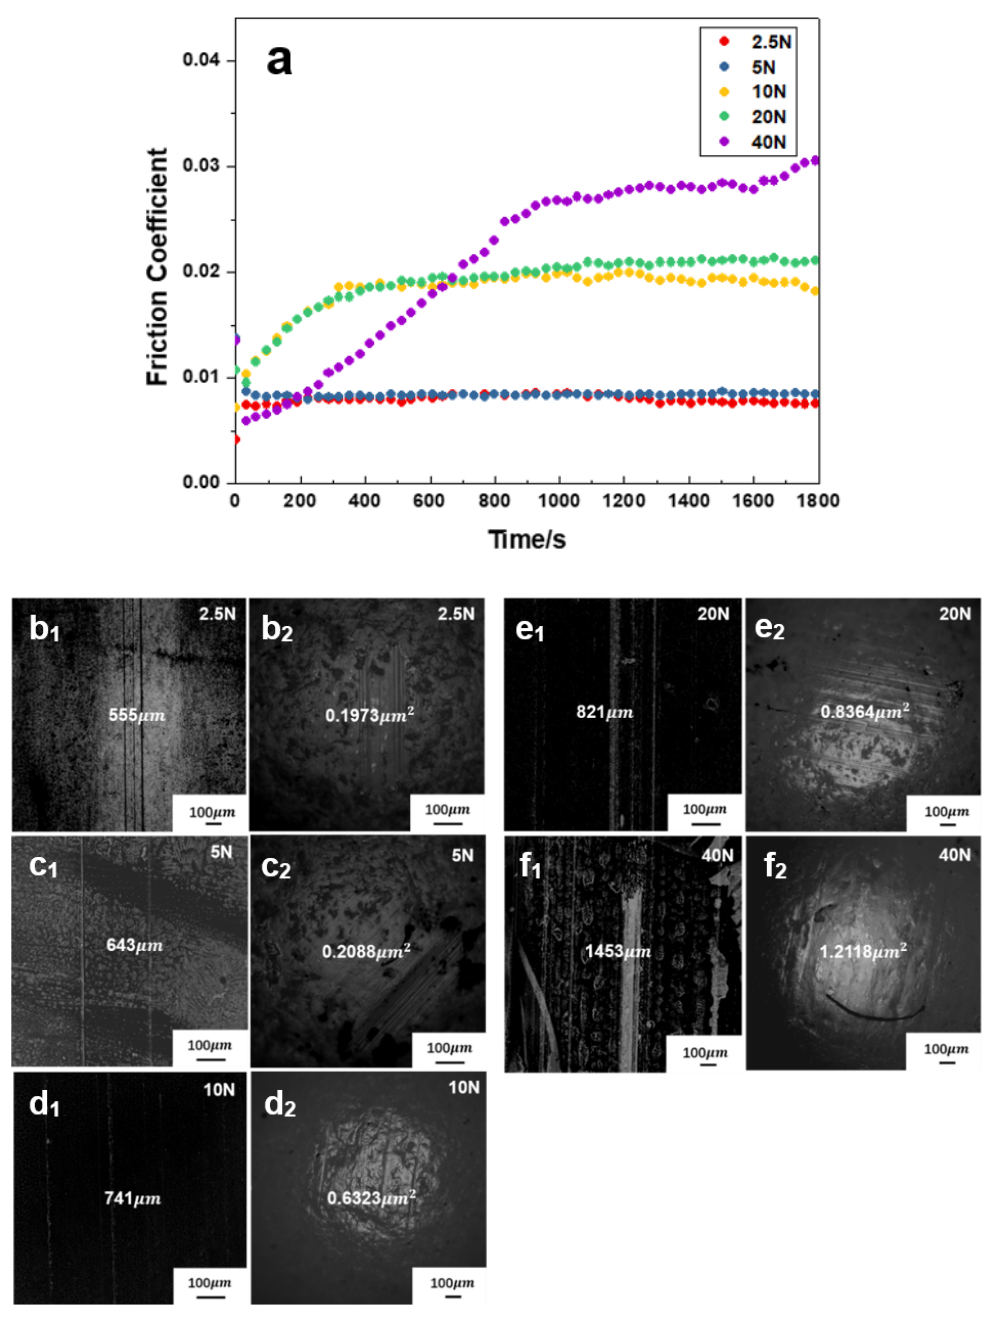
Figure 9. Tribological properties of organic PVPA-coated Ti6Al4V under different loads: ( a ) friction coefficient versus time; ( b 1 – f 1 ) wear morphologies of organic PVPA-coated Ti6Al4V under loads of ( b 1 ) 2.5 N, ( c 1 ) 5 N, ( d 1 ) 10 N, ( e 1 ) 20 N, and ( f 1 ) 40 N; ( b 2 – f 2 ) wear morphologies of PTFE balls (tribo-pairs of organic PVPA-coated Ti6Al4V under loads of ( b 2 ) 2.5 N, ( c 2 ) 5 N, ( d 2 ) 10 N, ( e 2 ) 20 N, and ( f 2 ) 40 N.